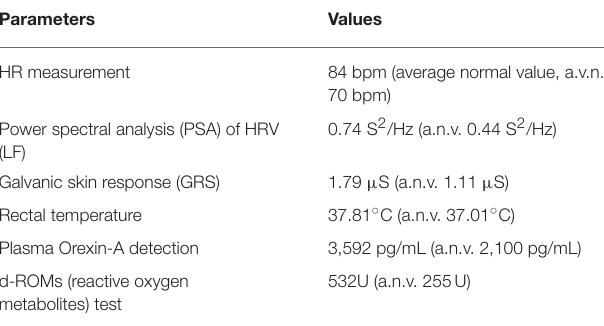
TABLE 2 | Results of the parameters analyzed in the case